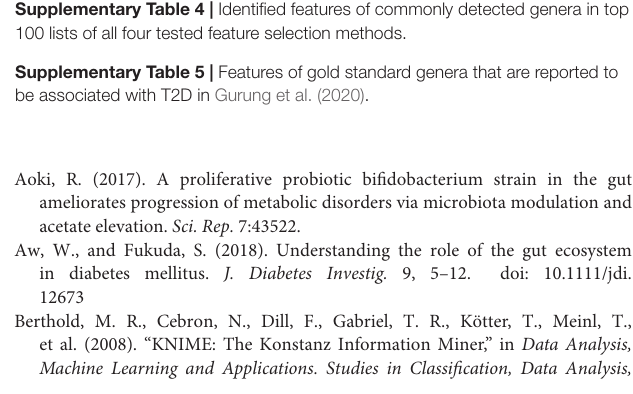
Supplementary Figure 1 | Preliminary performance evaluation results for T2D-associated metagenomics dataset using 10 fold cross-validation. Comparative evaluation of different classifiers using different feature selection methods based on (A) ROC area, (B) accuracy, and (C) F-measure. Supplementary Figure 2 | Numbers of identified genus, which are selected by different feature selection algorithms. The commonalities between the selected genus in different methods are also illustrated. Supplementary Figure 3 | Selection of the optimum number of the clusters for the (A) controls and (B) T2D patients. Using the elbow method, four clusters are found as the optimum number of clusters for both the controls [as shown in panel (A) ] and T2D patients [as shown in panel (B) ]. Supplementary Table 1 | Preliminary analysis results for T2D-associated metagenomics dataset using 10 fold cross-validation. Evaluation of different classification methods based on different performance measures (a) without feature selection and after applying (b) CMIM, (c) mRMR, (d) FCBF, and (e) SKB feature selection algorithms. Supplementary Table 2 | Top 100 selected features for each feature selection method and 15 commonly identified features among these four lists. Supplementary Table 3 | Top 500 selected features for each feature selection method and 199 commonly identified features among these four lists. Supplementary Table 4 | Identified features of commonly detected genera in top 100 lists of all four tested feature selection methods. Supplementary Table 5 | Features of gold standard genera that are reported to be associated with T2D in Gurung et al.